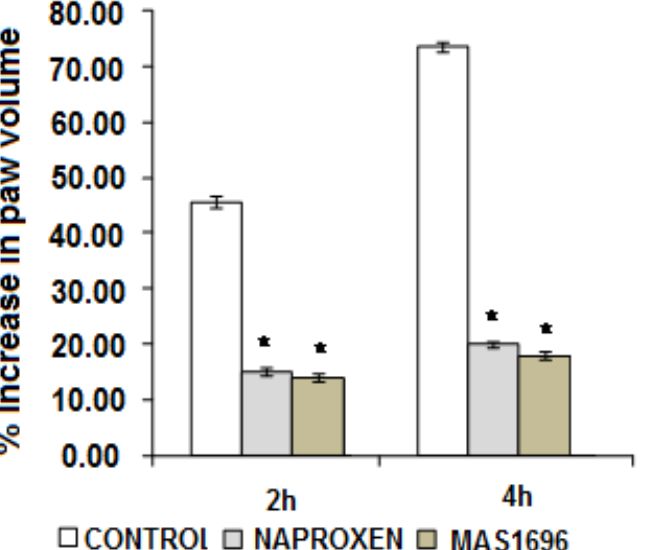
Figure 7. Anti-inflammatory activity of S -naproxen and MAS1696. * p < 0.05 as compared to control and naproxen. Results presented are mean ± S.E.M ( n = 6).